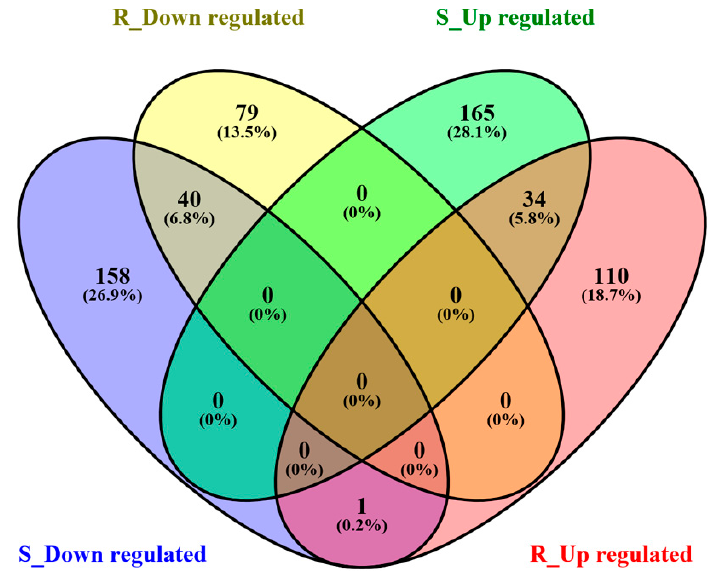
Figure 1. A Venn diagram showing the numbers of up- and down-regulated gut genes in S- and R-strain larvae of O. nubilalis fed transgenic corn leaves expressing Cry1Ab toxin as compared with those fed non-transgenic corn leaves. S_Down regulated (slate blue), S_Up regulated (green), R_Down regulated (yellow), and R_Up regulated (salmon) denote down- and up- regulated gut genes in S- and R-strains of O. nubilalis larvae fed transgenic corn leaves expressing Cry1Ab for 6 h, respectively.